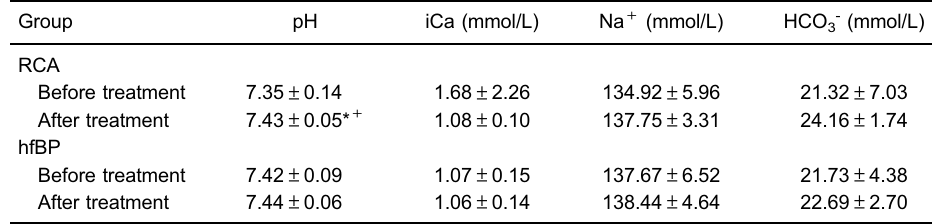
Table 6. Main metabolic and electrolyte parameters before and after the treatment of patients with multiple organ dysfunction syndrome treated with regional citrate anticoagulation (RCA) or heparin-free blood puri fi cation (hfBP).